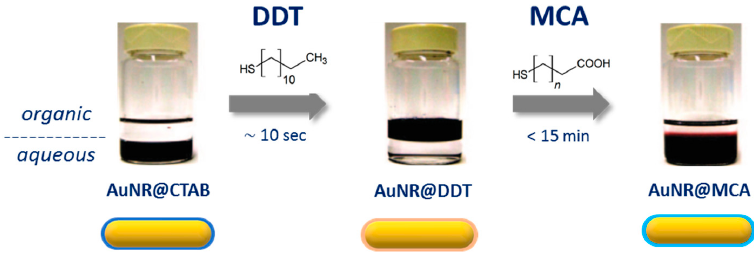
Figure 17. Round-trip” phase transfer method to prepare a DNA-AuNR bioconjugate [153]. Gates and coll. reported an alternative two-step procedure where the initial CTAB layer is temporarily replaced by loosely bound PVP and SDS, which are in turn replaced by thiolated-ssDNA applying salt screening as above. The number of DNA strands per NP depended on the initial DNA/AuNR ratio and reached saturation at a ratio of ≥ 25,600:1 with a maximum loading of 870 ± 60 DNA strands per NP [154].